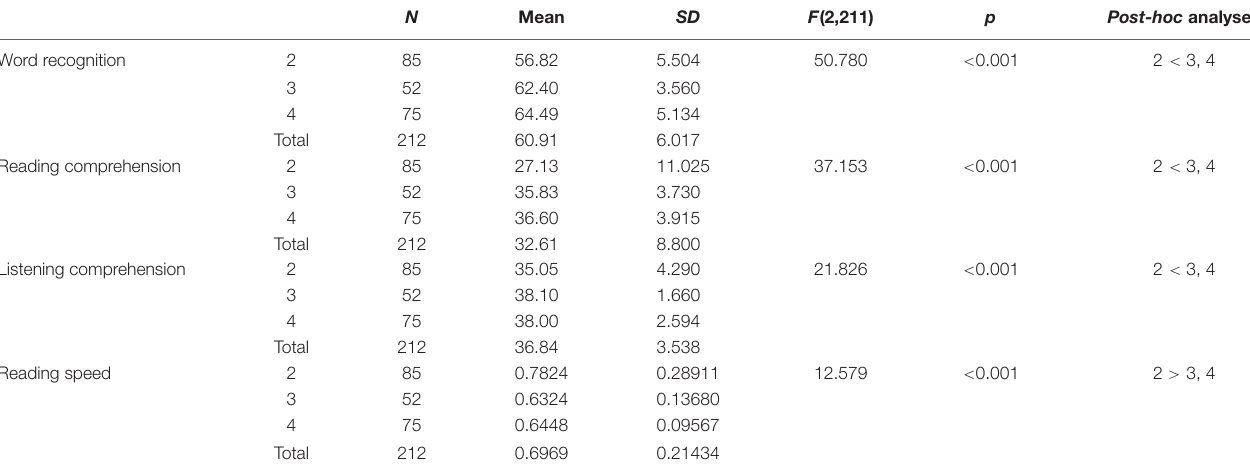
TABLE 1 | Descriptive and inferential statistics of grade effect on listening and reading measurements. N